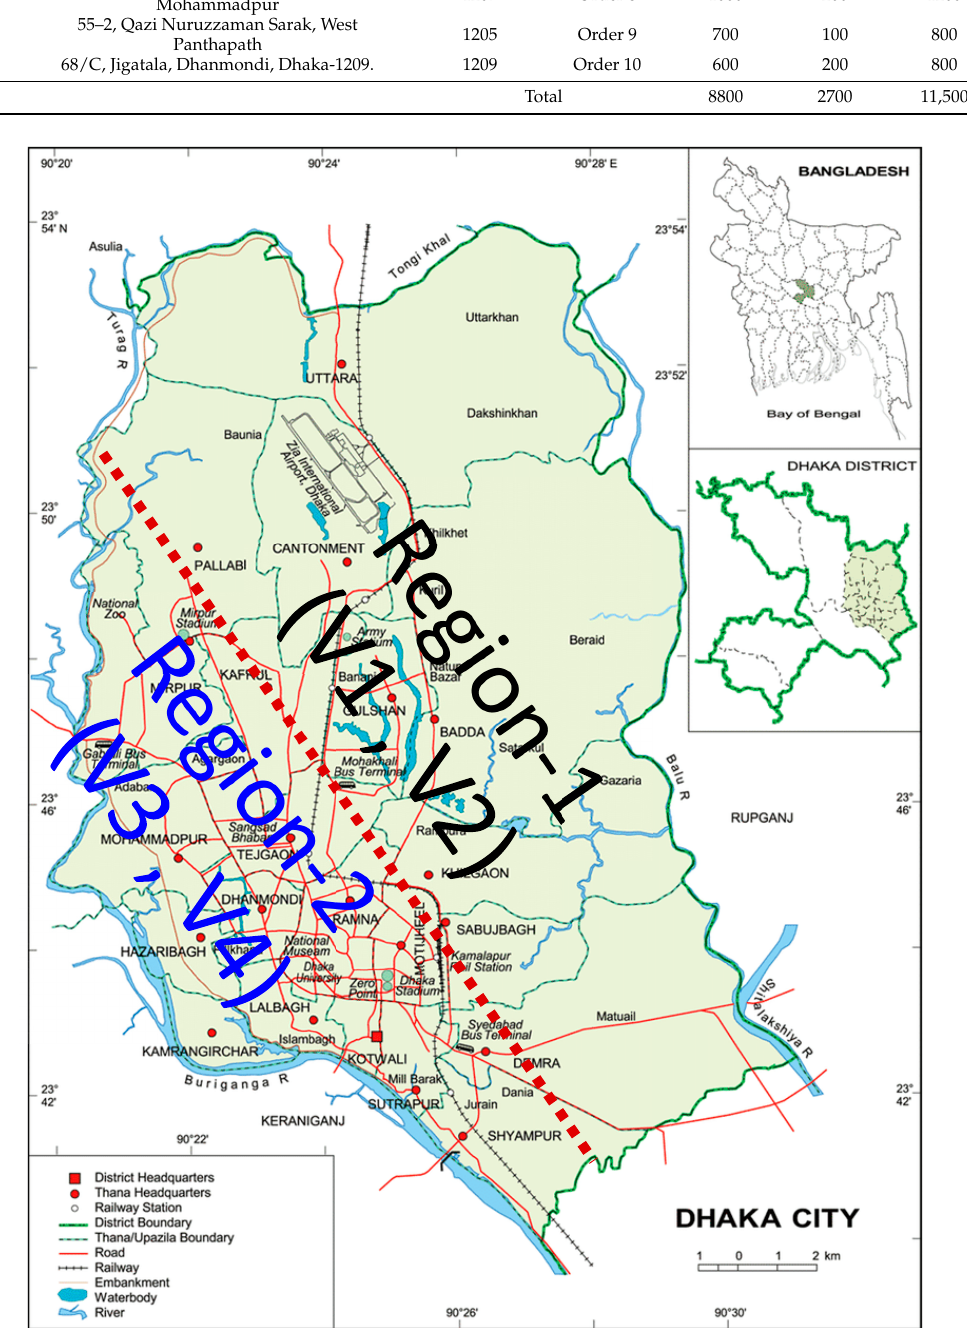
Figure 4. Vehicle coverage area allocation for Region-1 and Region-2 as shown in the map of Dhaka city.